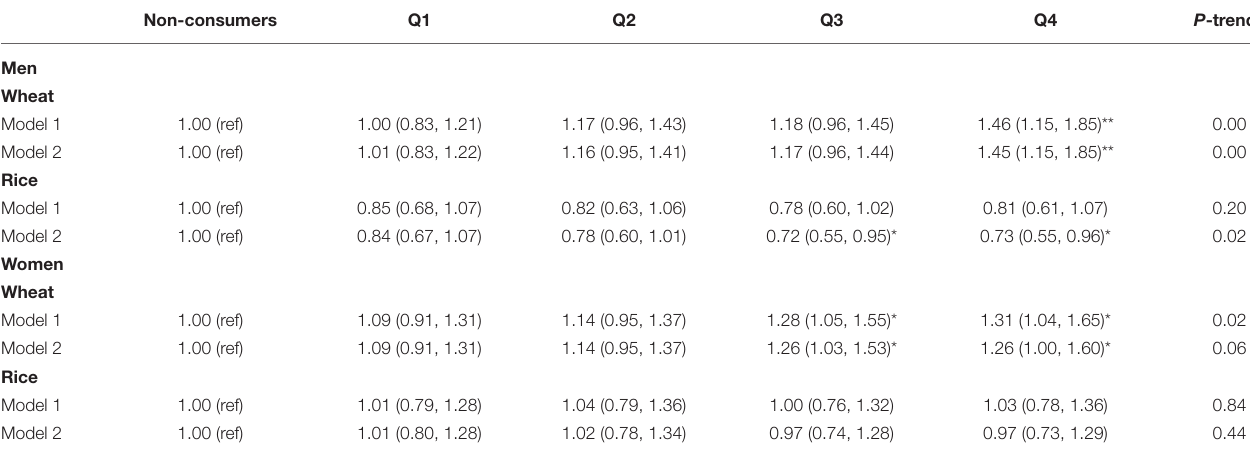
TABLE 3 | Odds ratios (ORs; 95% CI) of overweight/obesity across levels of wheat and rice consumption among Chinese adults, CHNS ac . Non-consumers Q1 P -trend